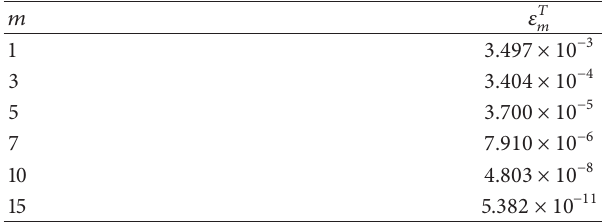
Table 1: The total residual square error 𝜀 𝑇 𝑚 for different approxima- tion order 𝑚 with 𝑐 0 = −0.18